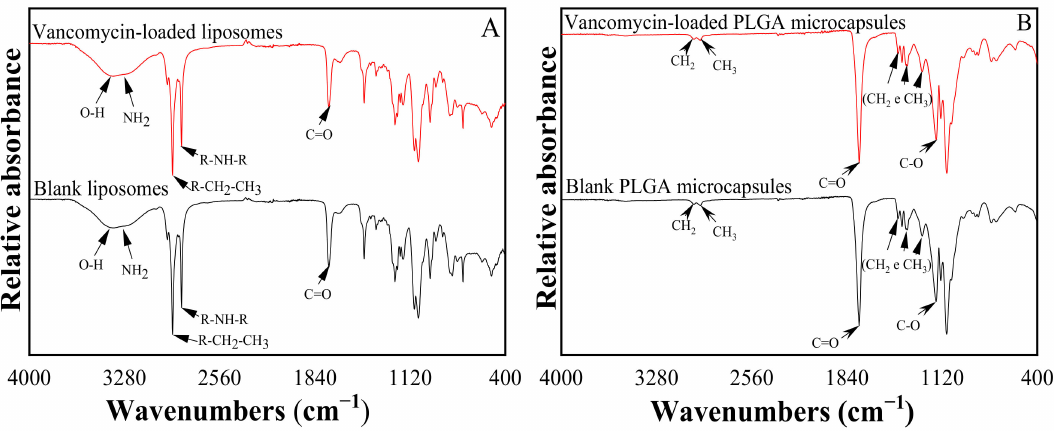
Figure 5. FTIR spectrum of ( A ) liposomes and ( B ) microcapsules. The FTIR spectrum of the synthesized PLGA samples is shown in Figure 5B. In the PLGA microparticle sample spectrum, it is possible to observe a thick band in the range between 1750 cm − 1 and 1740 cm − 1 , a characteristic range of carbonyl (C=O), present in the two monomers. Grouping band (C-O), between 1300 cm − 1 and 1150 cm − 1 can be observed, which is characteristic of ester groups. The absence of absorption bands between 3600 and 3400 cm − 1 in Figure 5B, characteristic bands of the hydroxyl group, indicates that the PLGA copolymers are